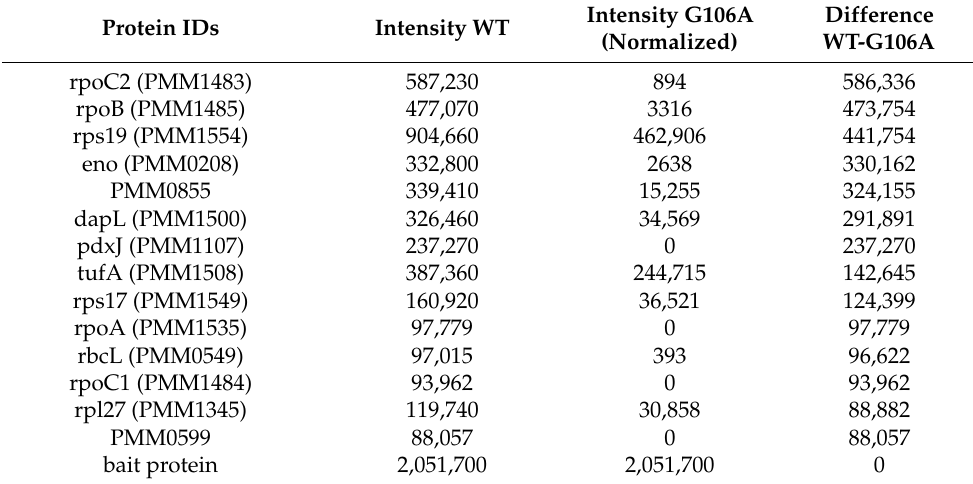
Table 1. Top list of proteins identified by LC-MS analysis, sorted by greatest difference in abundance between pMarR WT and pMarR G106A protein pull-down experiments. Intensity values of pMarR G106A pull-down data were normalized based on pMarR WT and pMarR G106 bait protein intensity